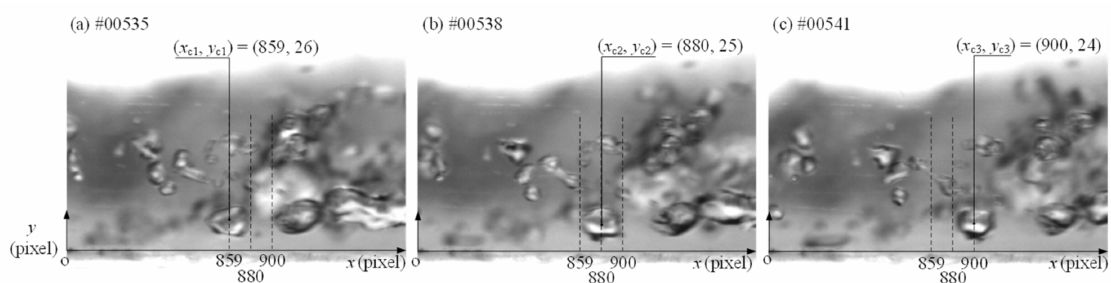
Figure 13. Examples for calculation of the instantaneous streamwise and transverse velocities by using